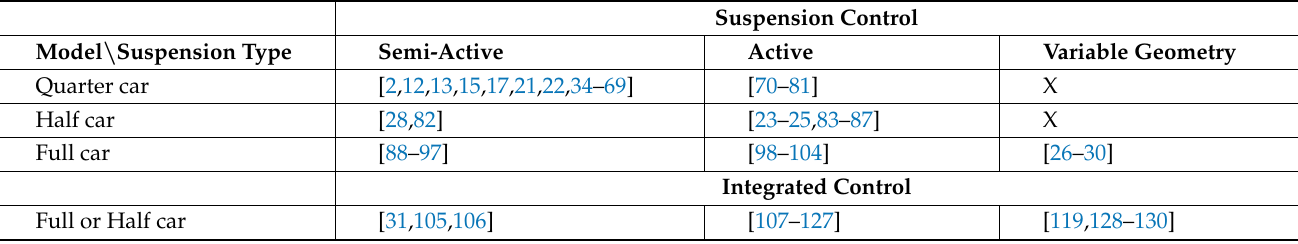
Table 1. List of studies carried out on suspension